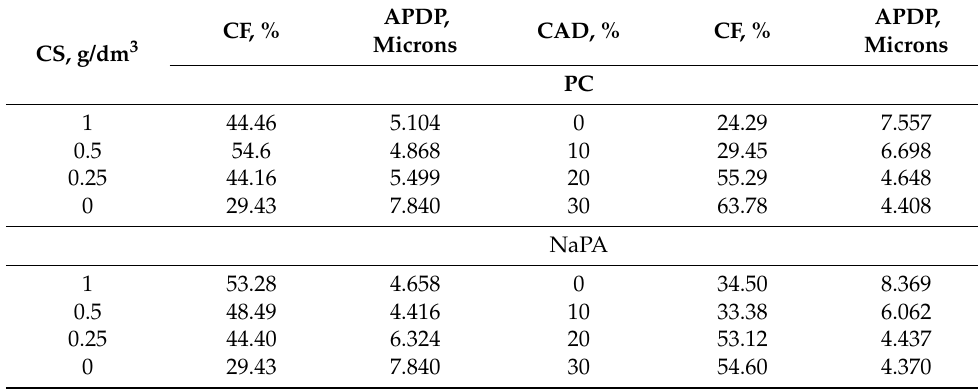
Table 6. Sample of response functions for each level of factors CS and